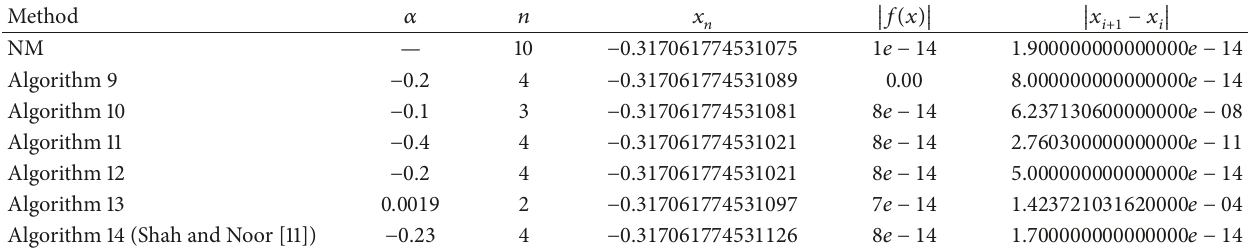
Table 2: Numerical results for Example 17 when 𝑝(𝑥) = 𝑒 −𝛼𝑥